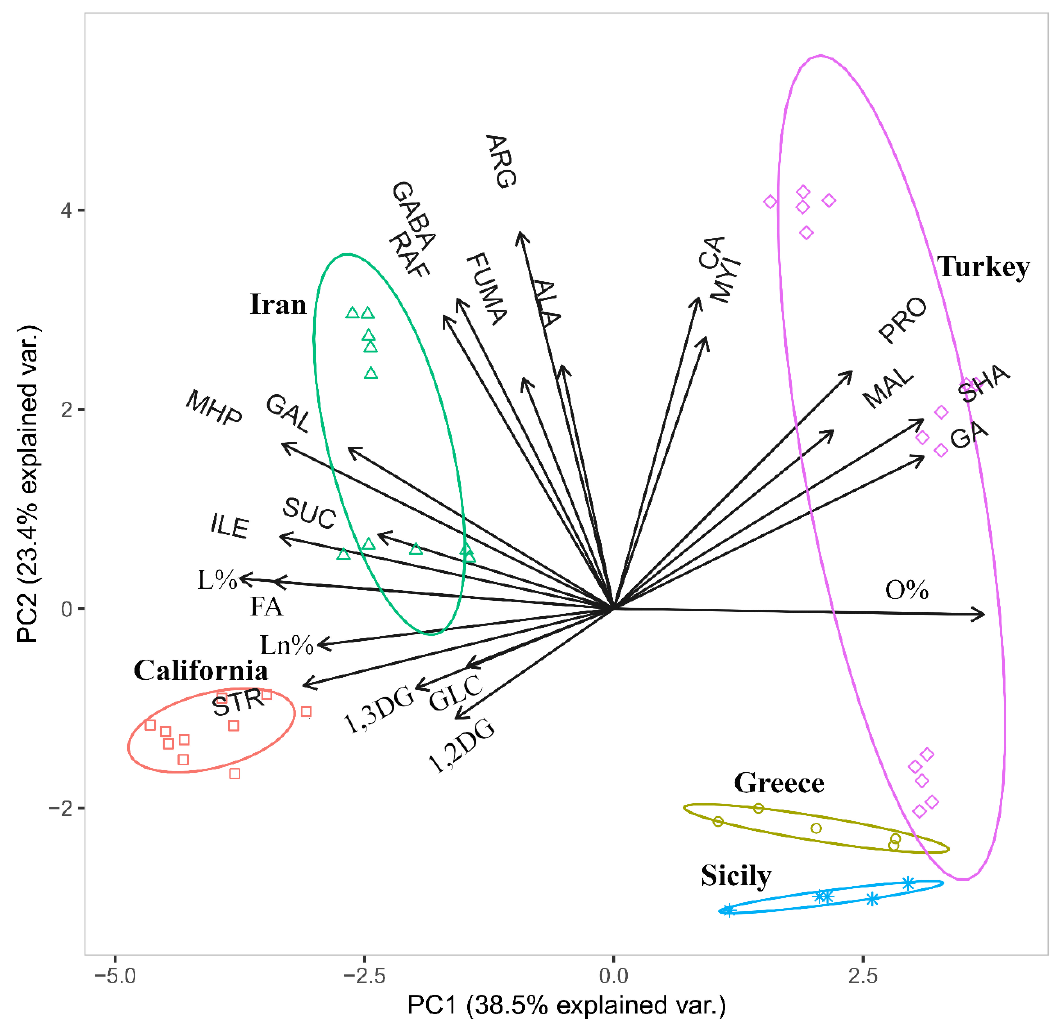
Figure 3. Graphical representation of the principal component analysis (PCA). It is a two-dimensional plot representing samples (marked as shaped spots) according to the most representative variables (loadings: represented by the radial harrows). The plot evidences are the definite clustering according to the different sample belongings.